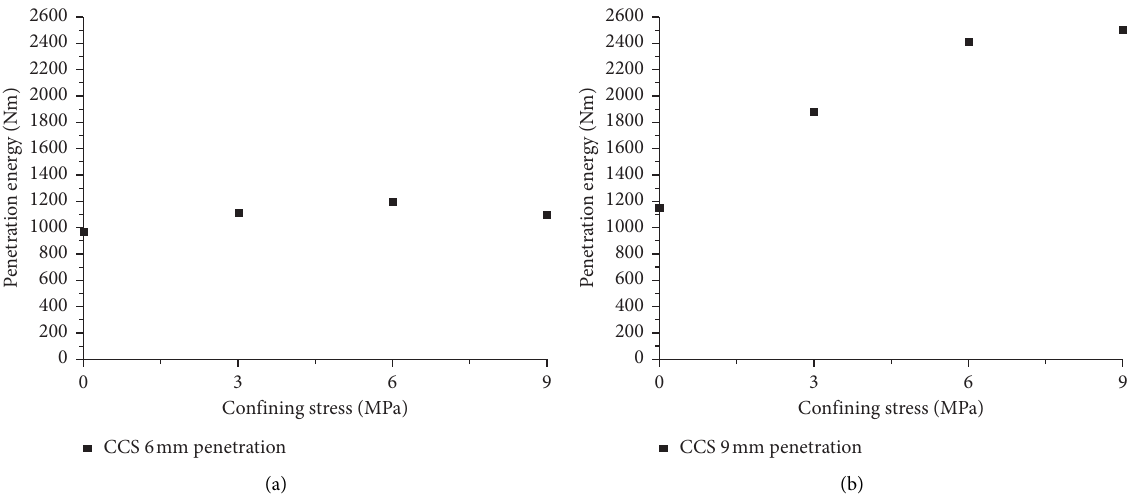
Figure 15: Penetration energy varies with confining stresses under the CCS disc cutter. (a) Ultimate penetration � 6mm; (b) ultimate penetration � 9mm.